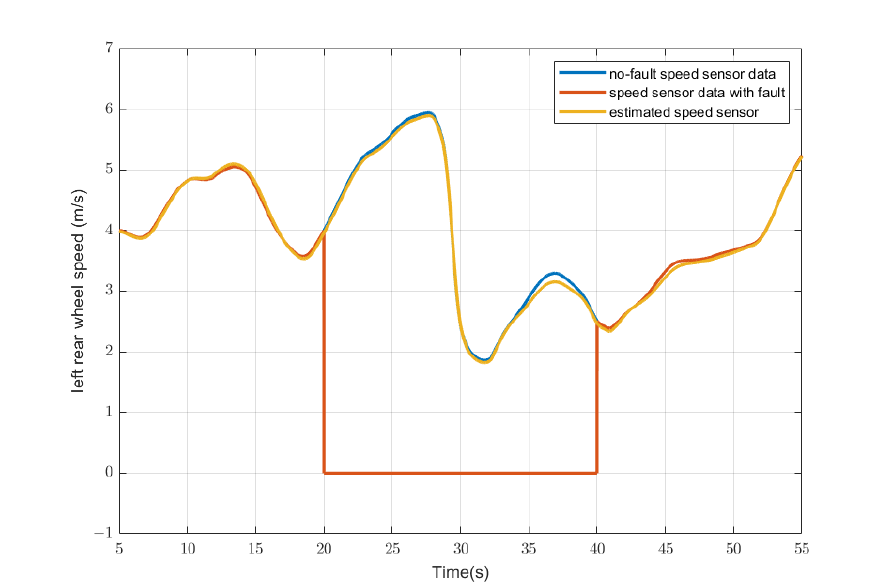
Figure 10. An example of sensor reconfiguration. The case is that the left rear speed sensor has a total-loss fault between 20 and 40 s. (Blue line: displayed sensor data with no-fault; red line: actual displayed sensor data with a fault; yellow line: estimated sensor data, which replaced the actual displayed sensor data).